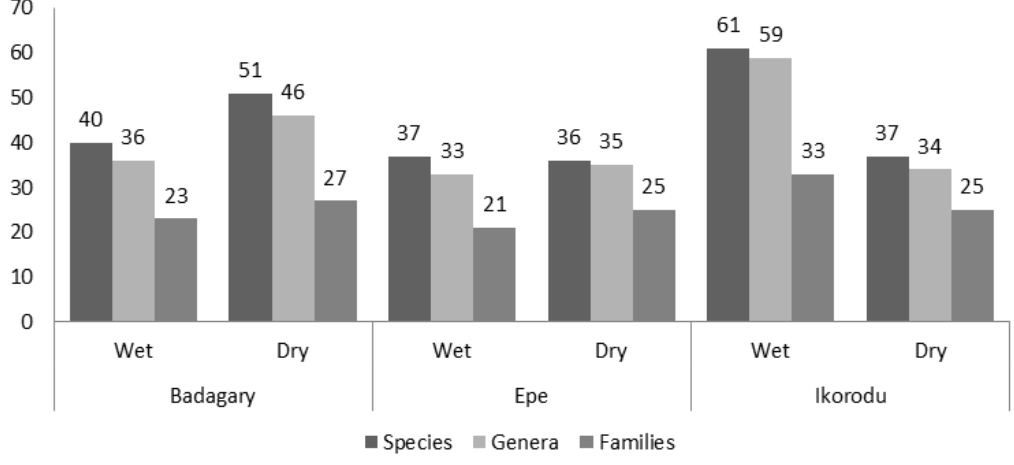
Figure 6. Taxonomic classification of species encountered in Badagry, Epe and Ikorodu areas of Lagos.